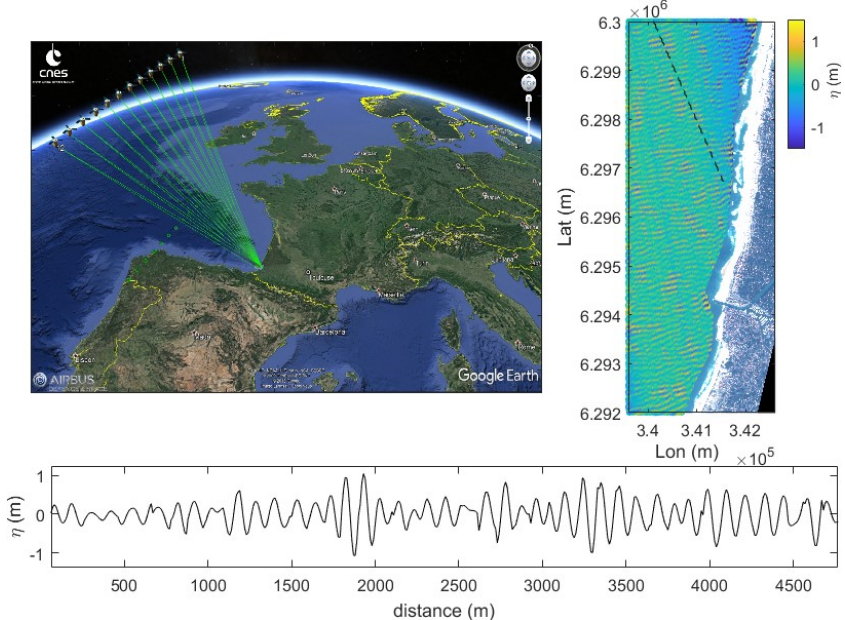
Figure 4. Reconstruction from the Pleiades satellite from image number 5 in the 11 images sequence. The upper left panel shows the satellite trajectory and region of interest, the upper right panel shows the reconstructed free surface superimposed with true color Pleiades image, where the wave train is clearly discernible, and the lower panel shows free surface along the transect showed above. Wave groups can be seen.